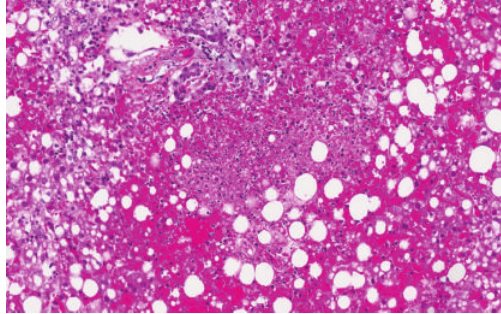
Figure 1: Zones of hepatocyte necrosis surrounded by hemorrhage without significant inflammation. (100x magnification; Hema- toxylin-Phloxine-Sa ff ron (HPS)